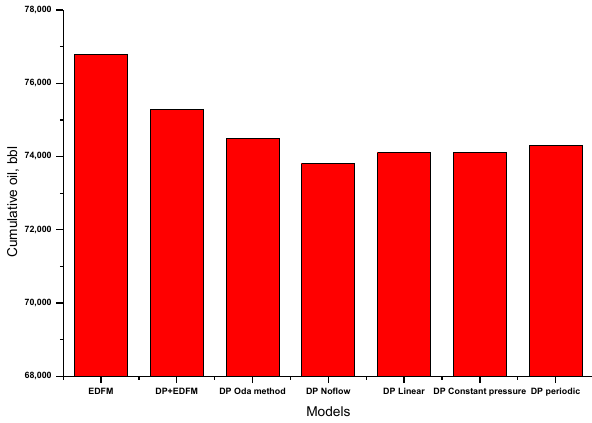
Figure 7. Simulation results for different models with capillary pressure for water flooding.